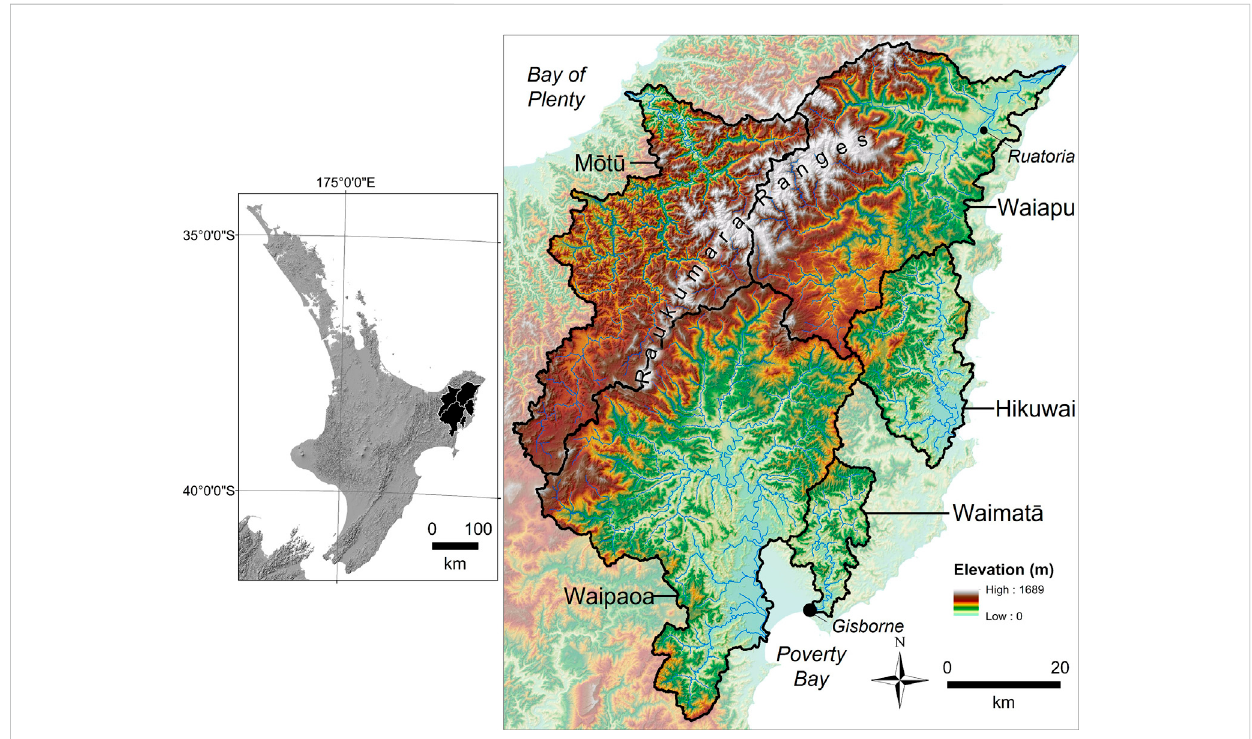
FIGURE 1 The Raukumara Ranges are the backbone of Tair ā whiti (East Coast Region of Aotearoa New Zealand). Although the fi ve study catchments (Waiapu (1758 km 2 ),Hikuwai(560 km 2 ), Waimat ā (370 km 2 ), Waipaoa (2,208 km 2 ),M ō t ū (1,373 km 2 ))have beensubject to similarlanduse impactsassociatedwith rapid deforestation, marked variability in recovery and rehabilitation prospects re fl ect signi fi cant differences in geomorphic responses to anthropogenic